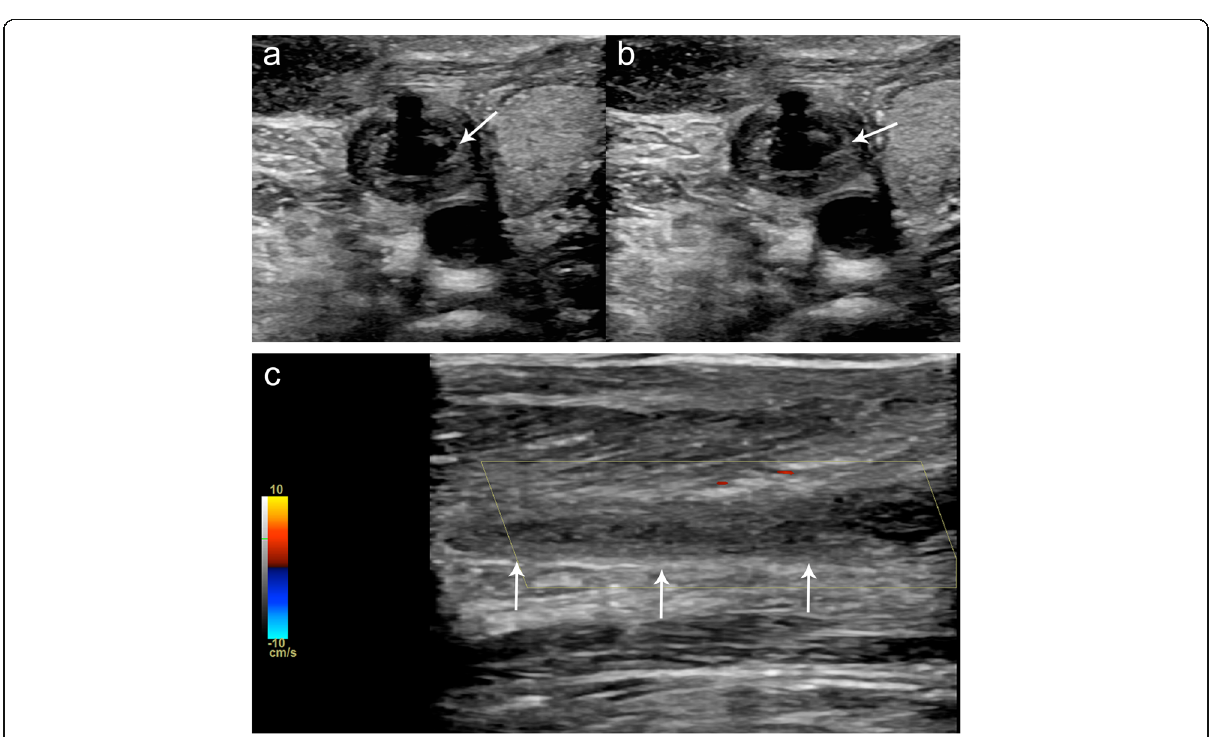
Fig. 8 Internal jugular vein thrombus. Grayscale ultrasound images of the same patient in Fig. 7 with ( a ) and without compression ( b ) demonstrating heterogeneous echogenic material within the jugular vein which was noncompressible (arrow), findings consistent with thrombus. Note the catheter within the vessel. c Color Doppler ultrasound image demonstrate lack of blood flow (arrows) in the internal jugular vein confirming the presence of thrombus